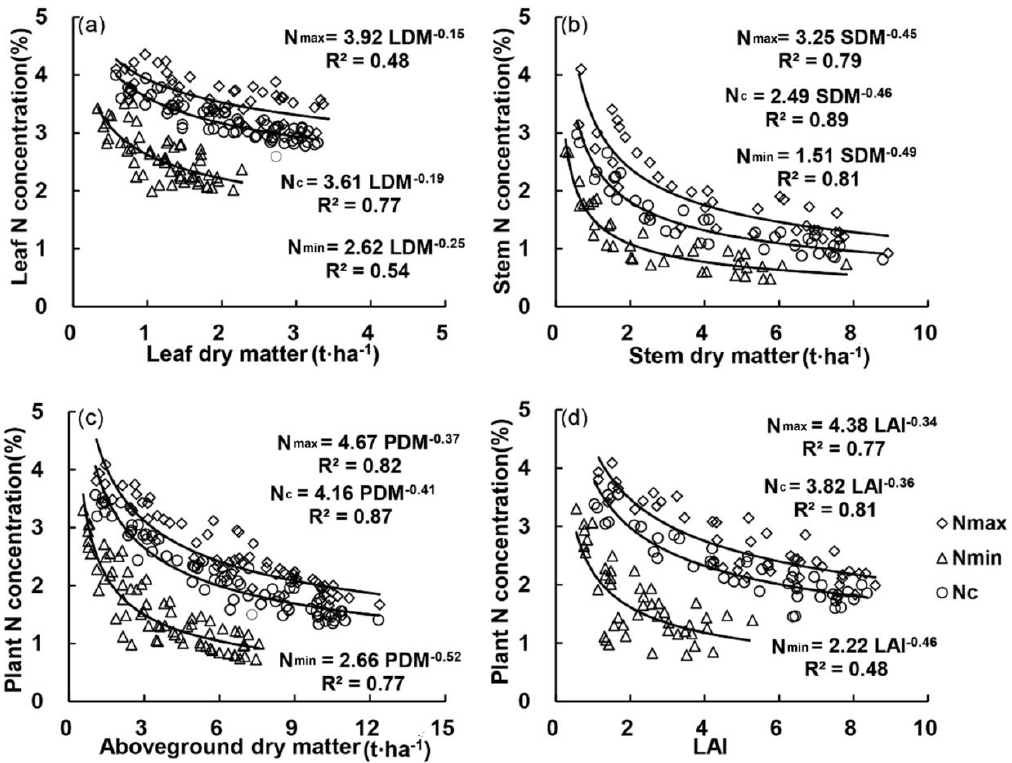
Figure 1. Comparison of critical, maximum, and minimum N dilution curves in wheat on a different basis ( a ): leaf dry matter basis; ( b ): stem dry matter basis; ( c ): plant dry matter basis; ( d ): leaf area index basis).